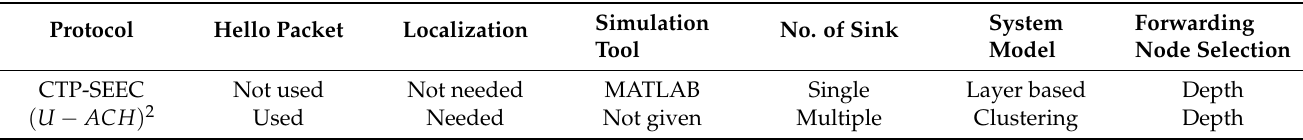
Table 2. Comparison of reactive routing